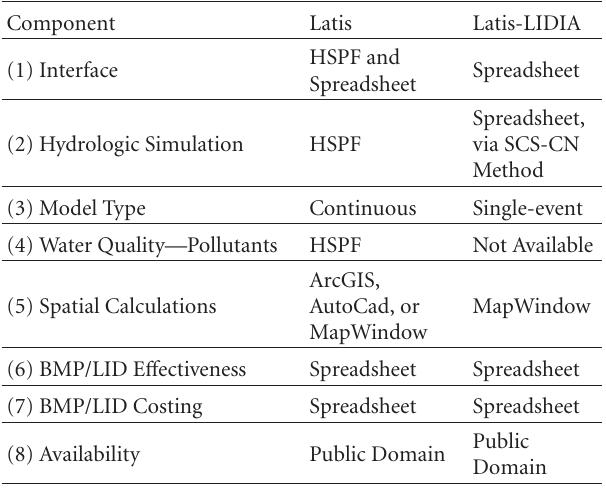
Table 1: Latis versus